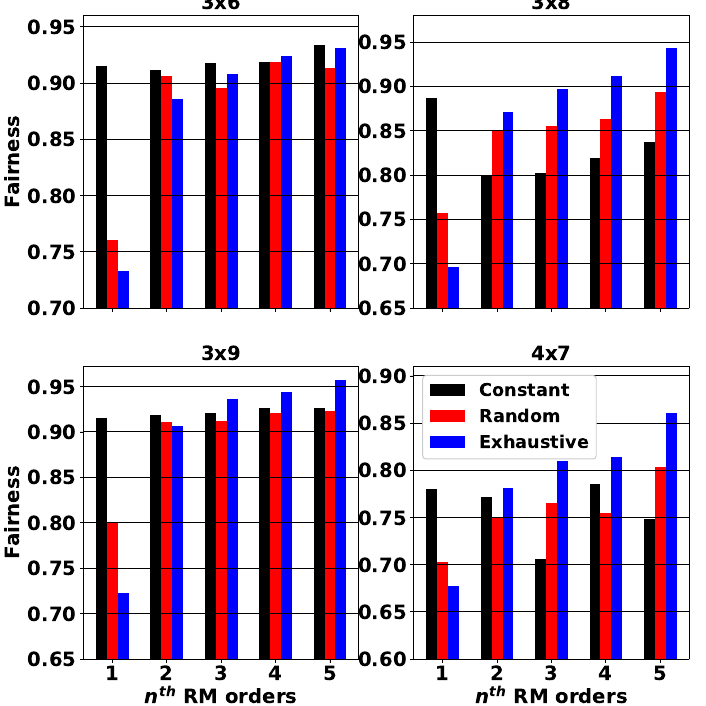
Figure 2. Average Fairness Indexes for Proposed and Exhaustive Schemes as n th Order Increases for Different GWsxUEs